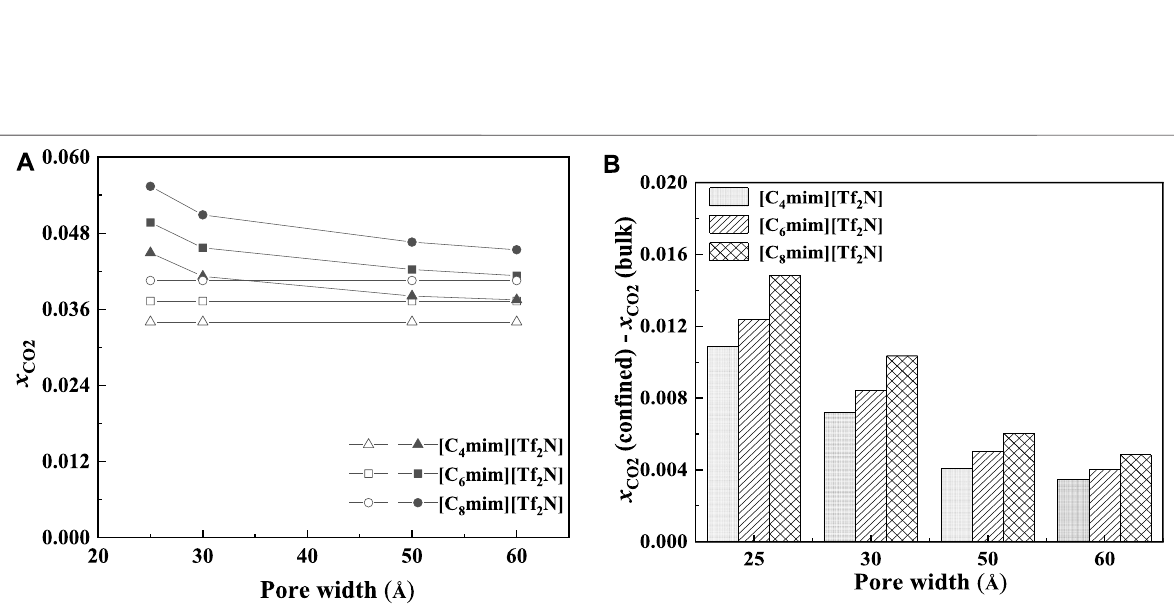
Frontiers in Chemistry |